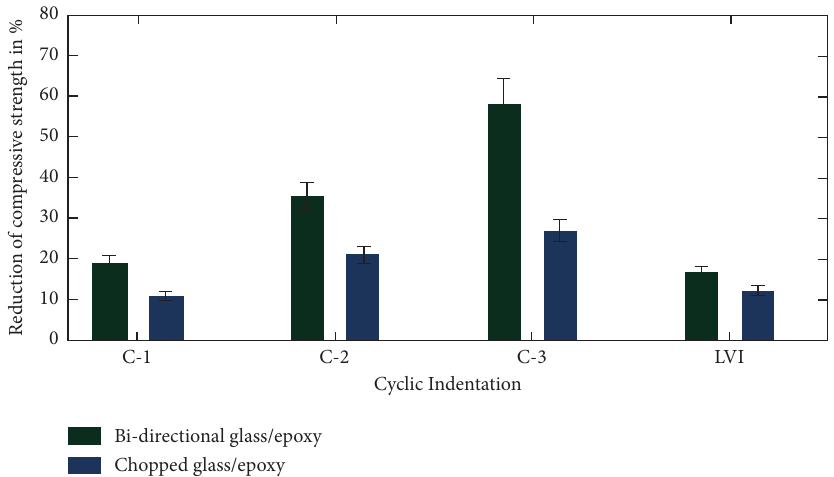
Figure 12: Percentage reduction of compressive strength of bidirectional and chopped